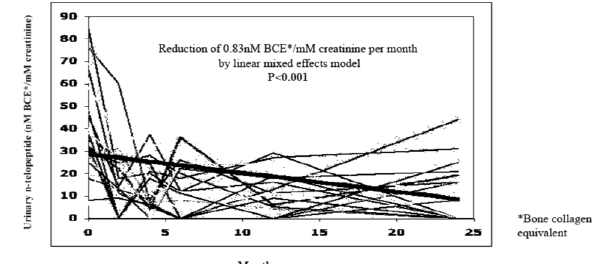
Fig. 1 Change in urinary n-telopeptide in 34 evaluable patients with baseline urinary n-telopeptide results. A reduction of 0.83 nM bone collagen equivalent (BCE) per mM creatinine per month ( p < 0.001) was seen over the 24-month study